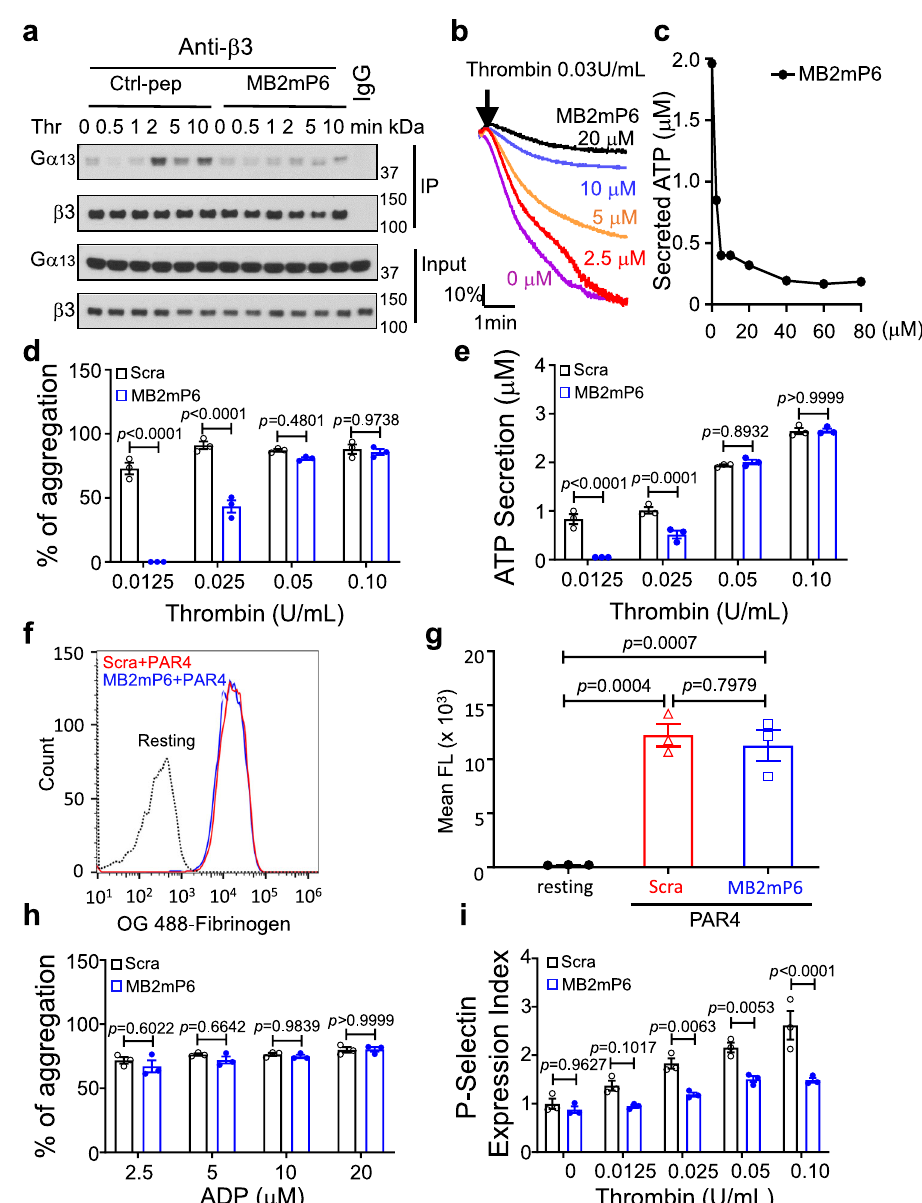
Fig. 3 The inhibitory effects of MB2mP6 on G α 13 interactions with β 3 integrins and on platelet function. a Representative immunoblots (from three independent experiments) of co-immunoprecipitation of β 3 integrin and G α 13 with anti- β 3 antibody in human platelets pretreated with MB2mP6 or control peptide HLPN (50 μ M) for 5 min and then stimulated with thrombin (0.025 U mL − 1 ) for various lengths of time. The immunoprecipitates and total cell lysates were immunoblotted with both anti- β 3 -integrin and anti-G α 13 antibodies respectively. b Representative thrombin-induced human platelet aggregation tracing showing a dose-dependent inhibition of aggregation by MB2mP6 HLPN. c Representative study showing 0.03 U mL − 1 thrombin- induced ATP secretion in washed human platelets is dose-dependently inhibited by MB2mP6 HLPN. d Effects of MB2mP6 HLPN on thrombin-induced mouse platelet aggregation induced by increasing doses of thrombin (all groups, n = 3, independent isolated platelets). e Effects of MB2mP6 HLPN on ATP secretion from mouse platelets stimulated with increasing doses of thrombin (all groups, n = 3, independent isolated platelets). f Effects of MB2mP6 HLPN on 500 μ M PAR4AP – induced binding of Oregon Green-labeled fi brinogen to mouse platelets. g Quanti fi cation of the binding of Oregon Green-labeled fi brinogen to mouse platelets induced by PAR4AP (500 μ M) pretreated with MB2mP6 or scrambled peptide HLPN (all groups, n = 3, independent isolated platelets). h Lack of effect of MB2mP6 HLPN on ADP-induced mouse platelet aggregation in presence of 100 μ g mL − 1 fi brinogen (all groups, n =